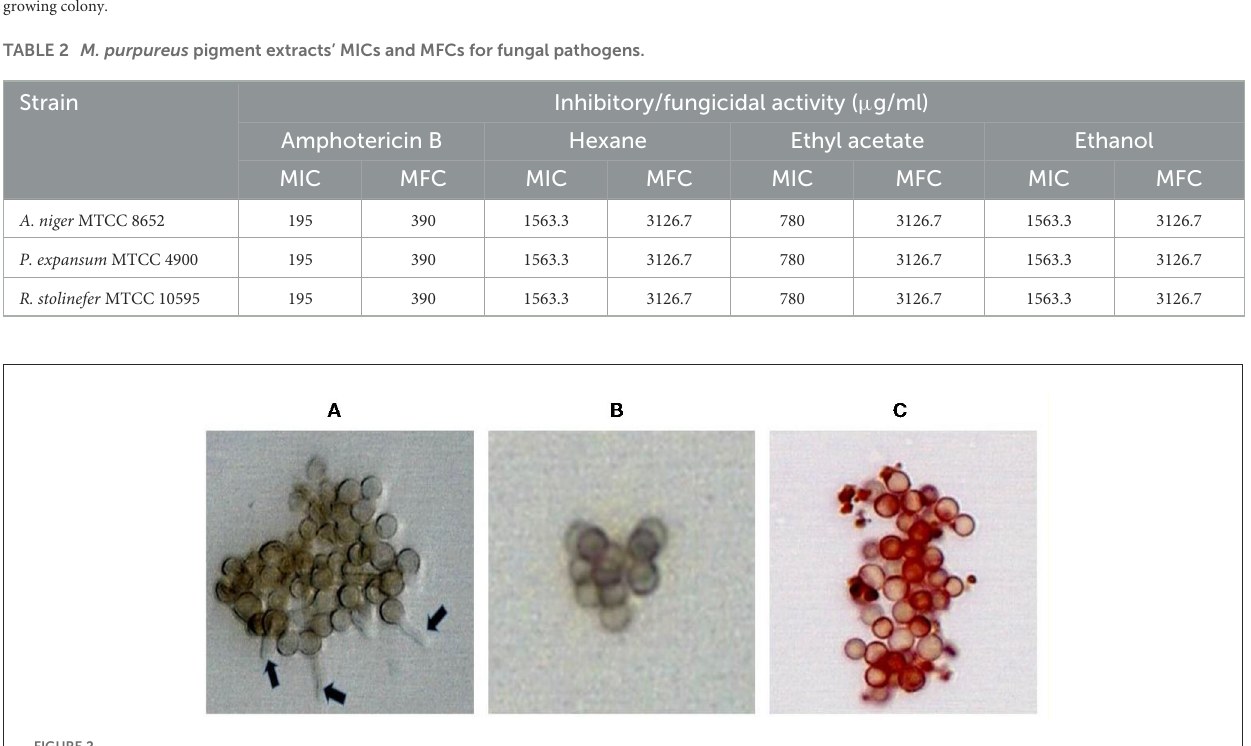
FIGURE2 Inhibition of A. niger MTCC 8652 spores germination treated with amphotericin-B (B) and pigment extract of M. purpureus (C). The germination tube formation observed (arrow) in the untreated spores (A) served as a